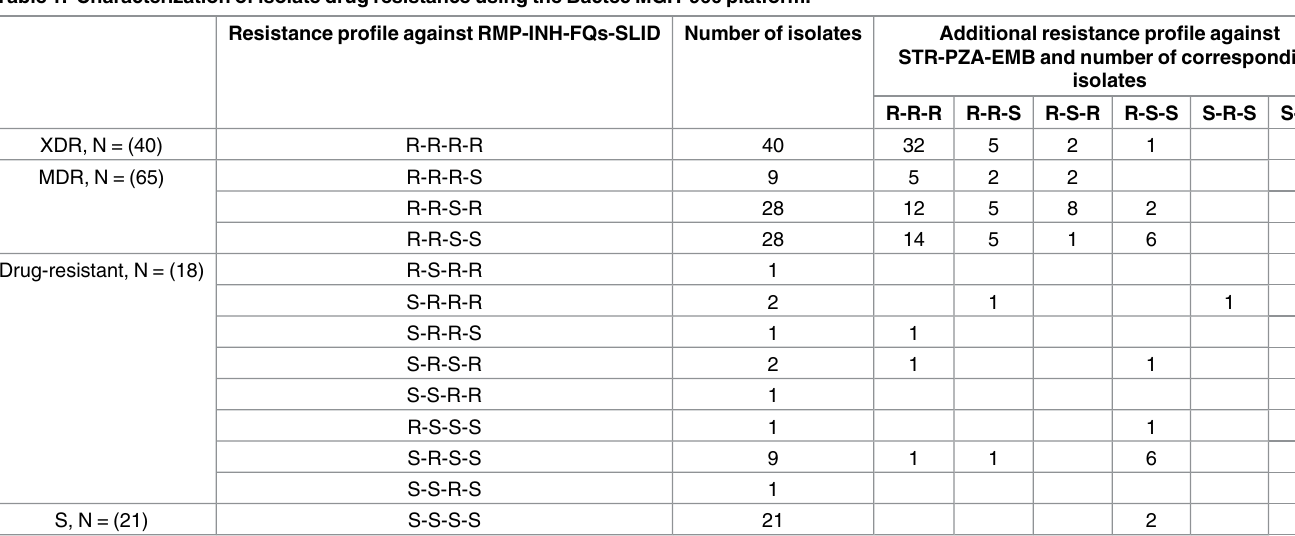
Table 1. Characterization of isolate drug resistance using the BactecMGIT 960 platform.